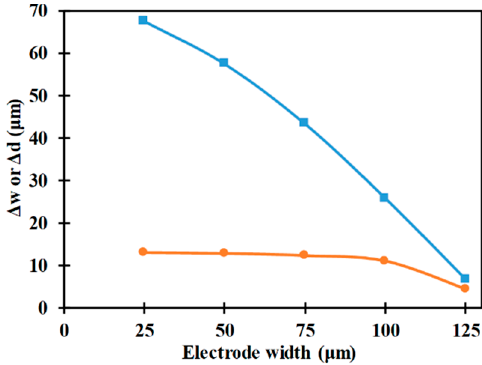
Figure 9. Variation of Δ w ( ■ ) and Δ d ( ● ) with electrode width ( r p = 2 μ m, L e = 2000 μ m, L ch = 2200 μ m, V 1 = V 2 = 12 V pp , W ch = 200 μ m, H ch = 50 μ m).